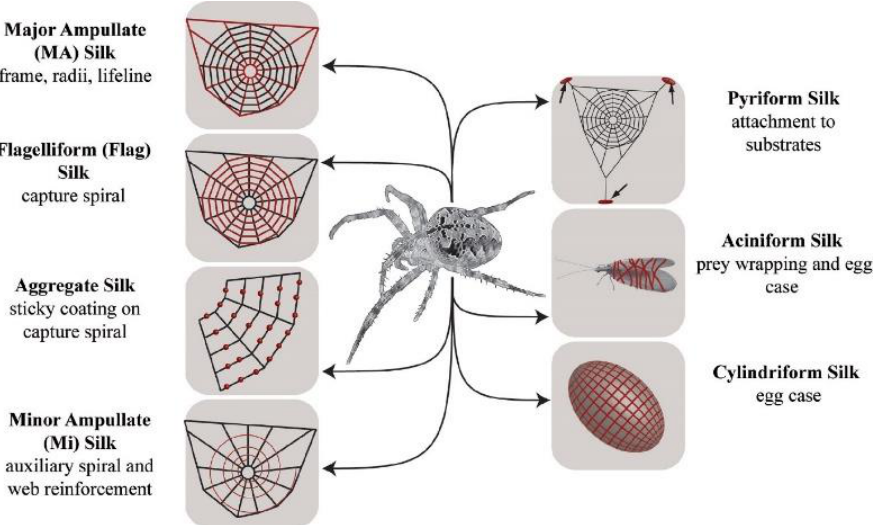
Figure 4. Schematic overview of different silk types produced by female orb-weaving spiders (Araneae). Each silk type (highlighted in red) is tailored for a specific purpose. Reproduced with permission from Elsevier from Eisoldt et al. [49].